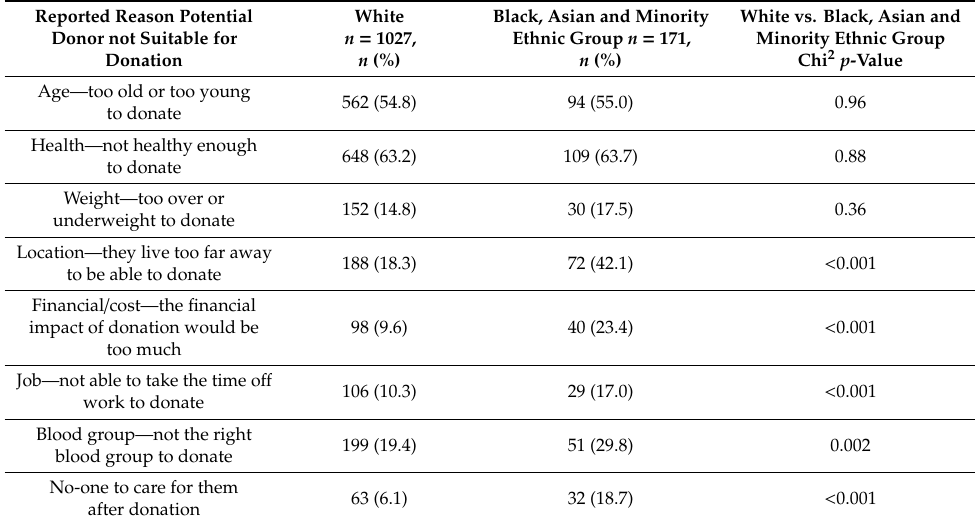
Table 2. Participant reported reasons relatives could not donate a kidney to